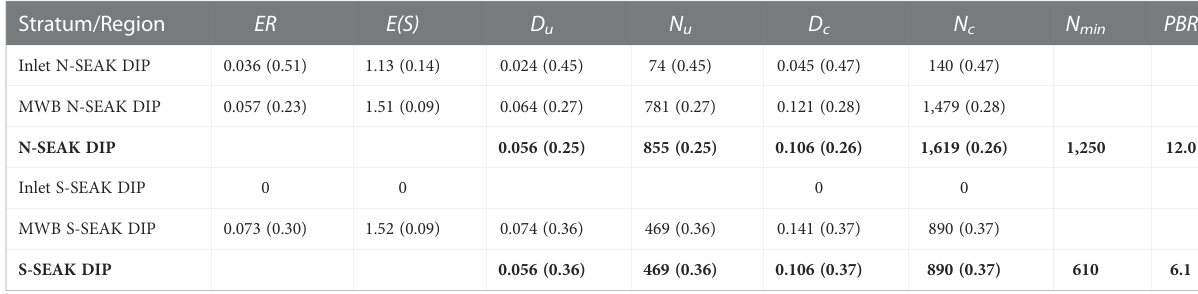
TABLE 2 Estimates (CV in parenthesis) of encounter rate (ER, groups/km), expected groups size (E[S], individuals), uncorrected and corrected density (D u and D c , individuals/km2), uncorrected and corrected abundance (N u and N c , individuals), minimum population size (N min ) and the Potential of Biological Removal (PBR) for harbor porpoise in SEAK inland waters. Rows in bold represent total estimates for the N-SEAK DIP and the S-SEAK DIP.